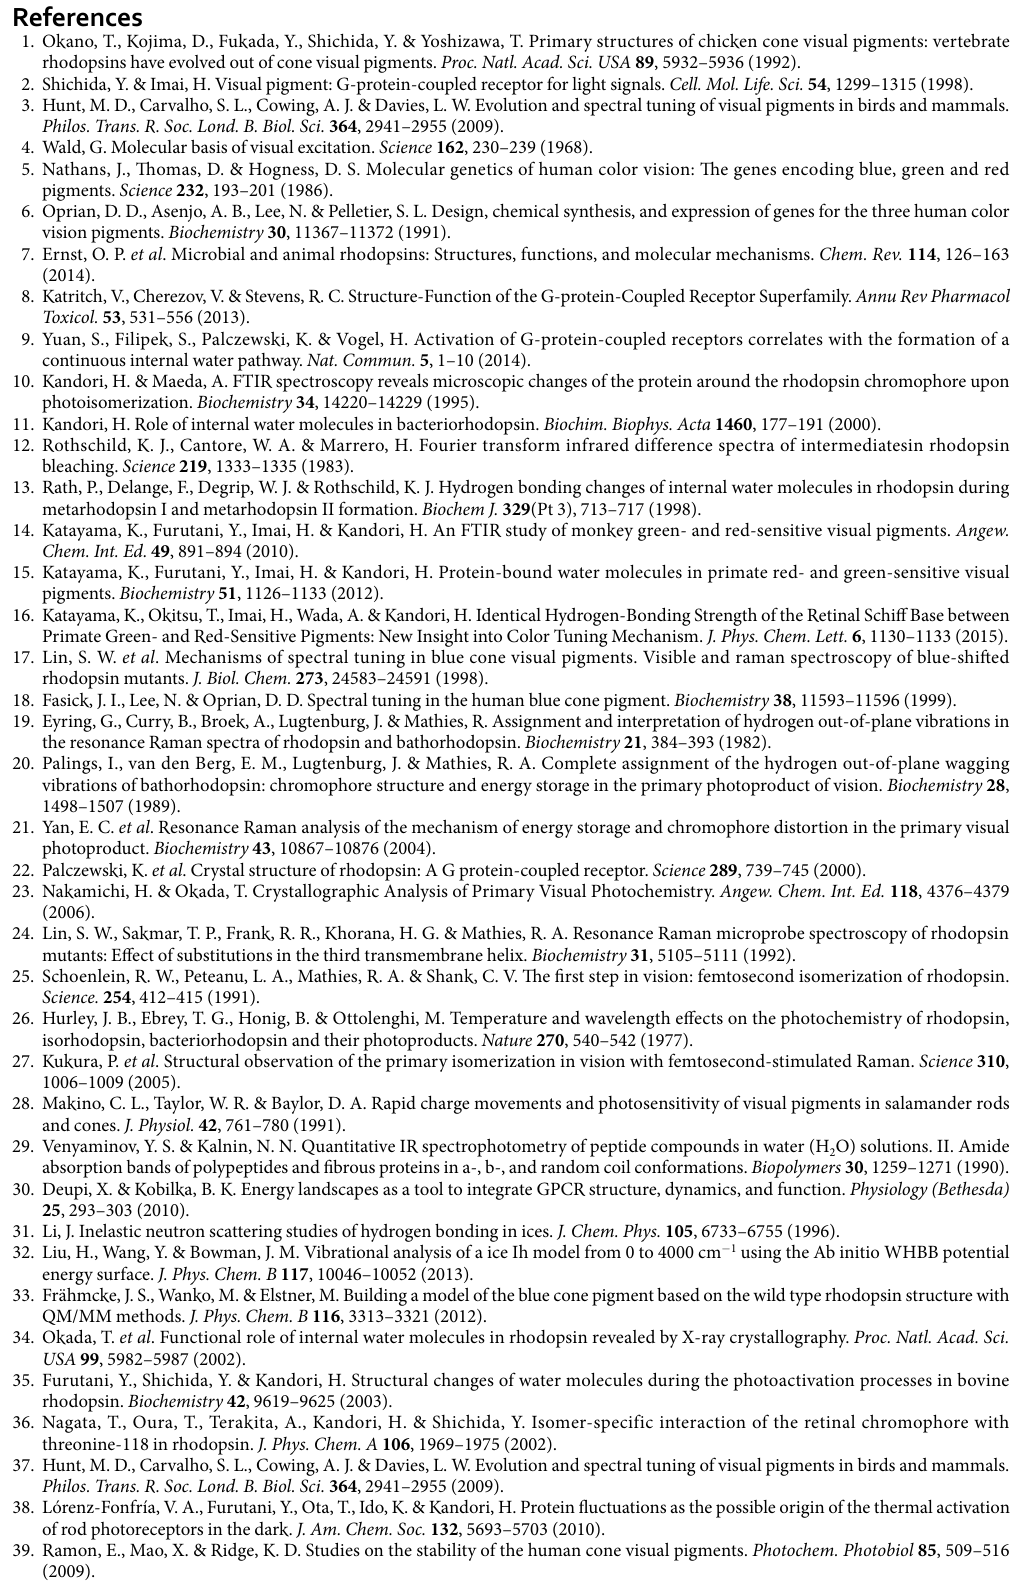
the samples were irradiated with 400 nm light (using an interference filter) for 5 min. For the reversion of the batho-intermediate state to the dark state, the samples were irradiated with > 520 nm light for 5 min. For each measurement, 128 interferograms were collected and 40 recordings were averaged. FTIR spectra were recorded at a 2 cm − 1